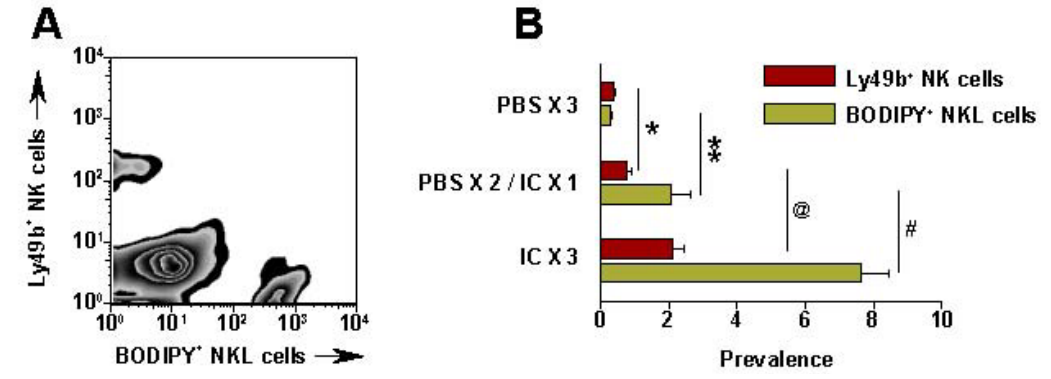
Figure 6. IT-IC facilitates migration of NK cells into tumor. SCID mice bearing s.c. M21 received IT-PBS (50 μ L) or IT-IC (10 μ g in 50 μ L) on day 27-29. (PBS × 3) = PBS on d 27, 28, 29; (PBS × 2/IC × 1) = PBS on d 27, 28, and IC on d 29; (IC × 3) = IC on d 27, 28, 29. On d 29, right after the last IT- PBS or IC, all mice received 5 × 10 6 BODIPY-labeled NKL cells IV. 24 h after the NKL cell injection, tumors were harvested, processed, stained and tested by flow for mouse Ly49b + NK cells and BODIPY + NKL cells. ( A ) Representative pattern from a (IC × 3) mouse; numbers are for the 3 (IC × 3) mice (Mean % ± SEM). ( B ) Data for all groups (represents 2 independent experiments).